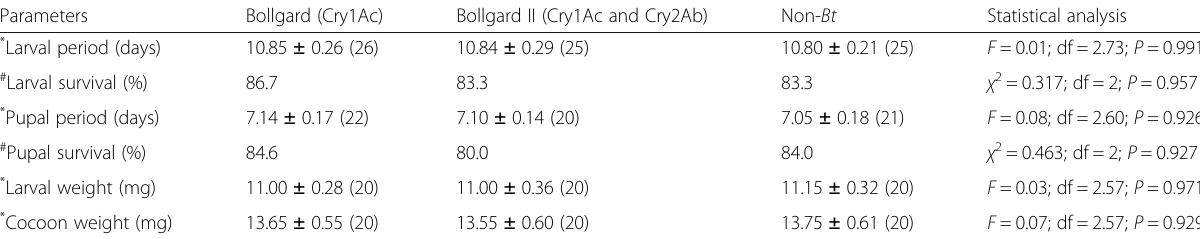
Table 2 Development time, survival and weight of Chrysoperla zastrowi sillemi fed on Bemisia tabaci reared on Bt and non- Bt cotton cultivars Parameters